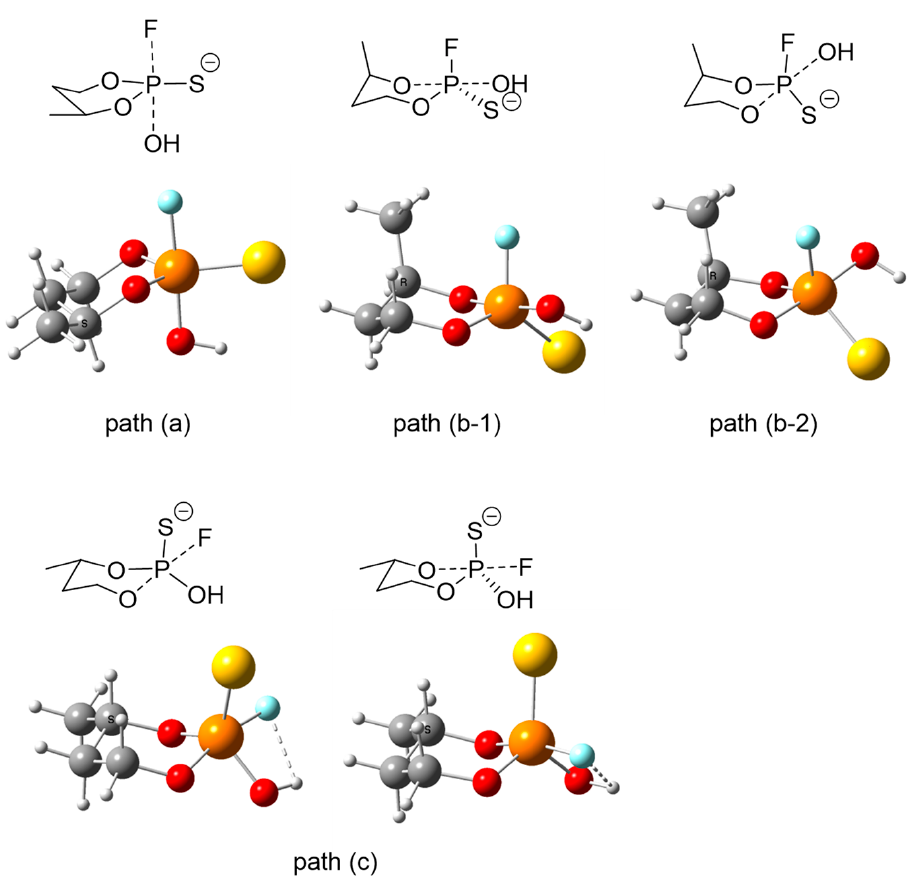
Figure 8. Structures of the P V intermediates resulting from attack of OH − on trans - 6 ( F ); for description of routes a , b and c see Scheme 21.